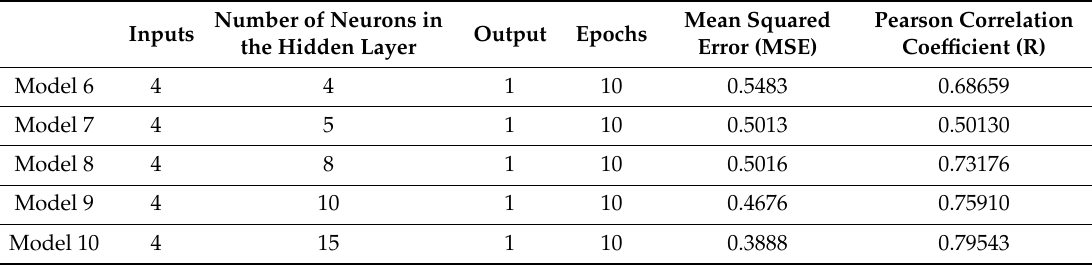
Figure 9. Architectural description of the model for ◦ Brix prediction using Fitnet. Table 3. Models using neural network Feedback prediction of Brix degrees.